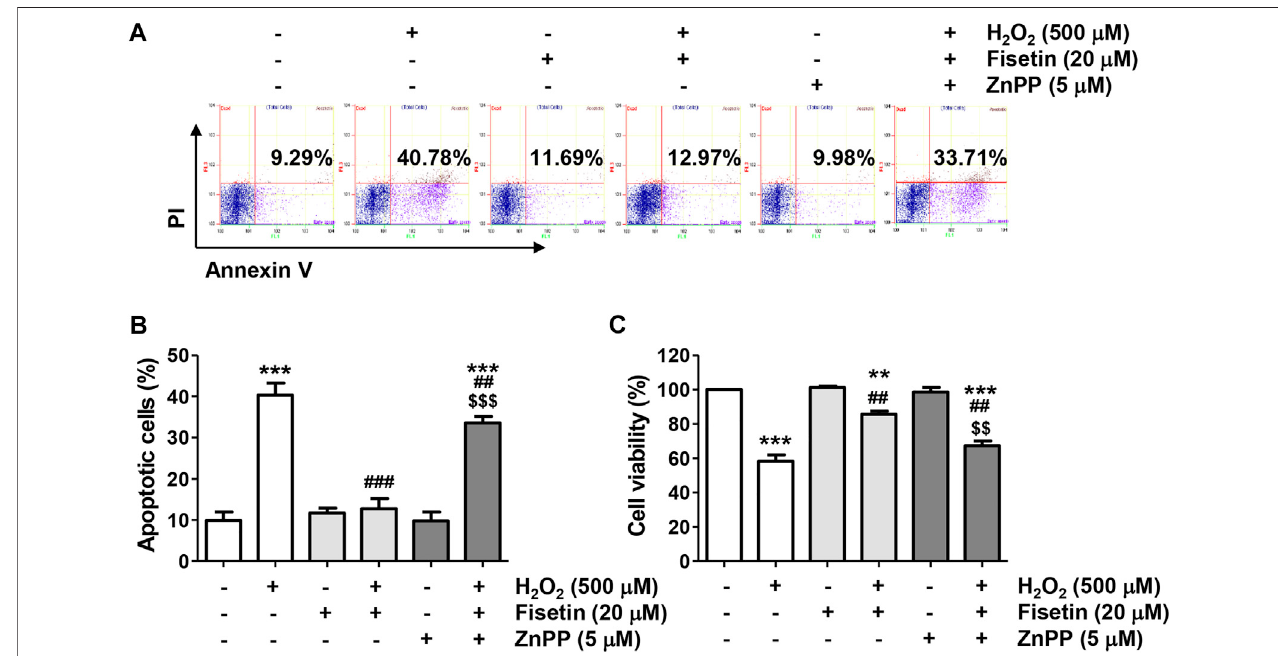
FIGURE 7 | The blocking activity of fi setin on apoptosis and survival inhibitory effects was counteracted in H 2 O 2 -treated ARPE-19 cells. Cells treated with 20 μ M fi setin and/or 5 μ M ZnPP for 1 h were further treated with 500 μ M H 2 O 2 for 24 h (A,B) Flow cytometry with annexin V/PI dual staining was performed. Representative histograms (A) and quantitative analysis (B) are shown. (C) Cell viability was measured by the CCK8 analysis for cells cultured under the same conditions. The blocking effect of fi setin on H 2 O 2 -induced apoptosis was signi fi cantly counteracted by ZnPP, and the cytotoxic protective effect of fi setin was also signi fi cantly moderated. (B,C) Graphs represent means with SD ( n = 3, ** p ˂ 0.01, and *** p ˂ 0.001 compared with control group; ## p ˂ 0.01, and ### p ˂ 0.001 compared with H 2 O 2 treatment group; $$ p ˂ 0.01 and $$$ p ˂ 0.001 compared with fi setin + H 2 O 2 treatment group.